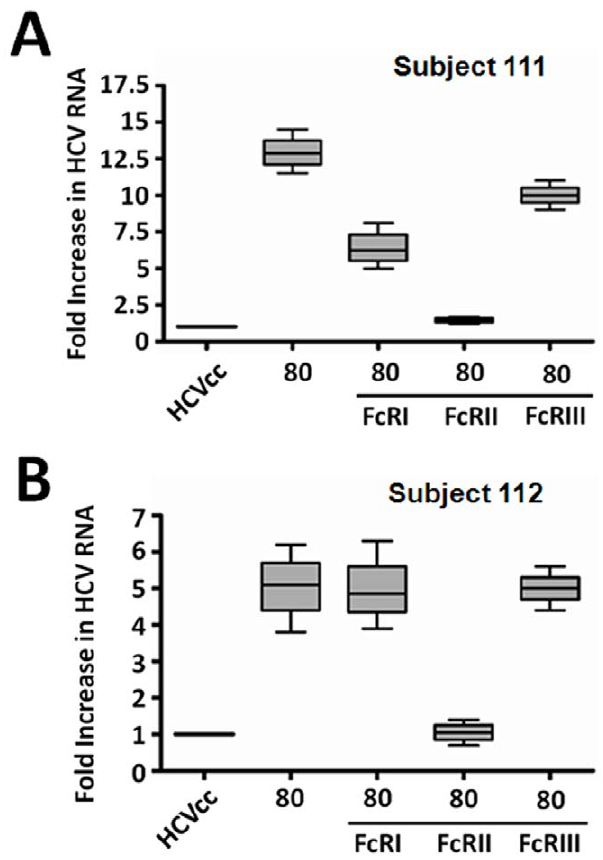
Figure 7. Blocking FcRII on hepatocyte surface leads to inhibition of ADE. HCV was incubated with vaccinee sera for 1 h prior to infection. Huh-7 cells were treated with antibodies known to block the binding activity of the individual Fc receptors 15 minutes prior to infection with the HCV/vaccinee sera mixture. Cells were incubated for 6 h, washed, and incubated for 4 days before RNA preparation and real-time PCR analysis for quantitation of HCV RNA by real-time